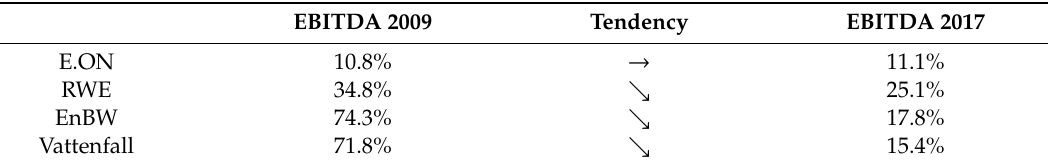
Table 2. Earnings before interest, taxes, depreciation, and amortization (EBITDA) contribution from conventional power generation [1].